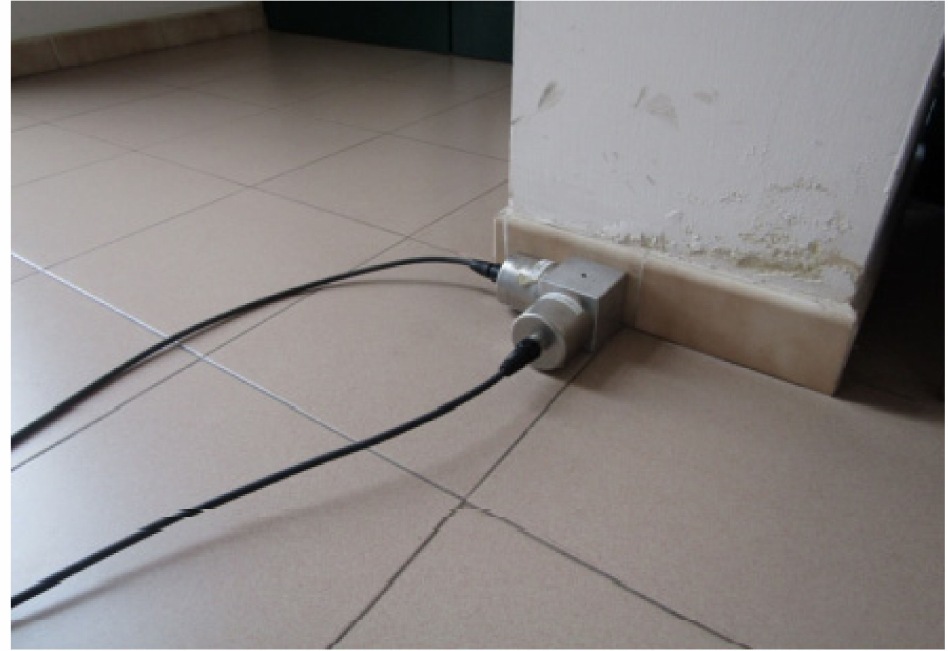
Figure 8. View of the sensors installed in one of the monitored